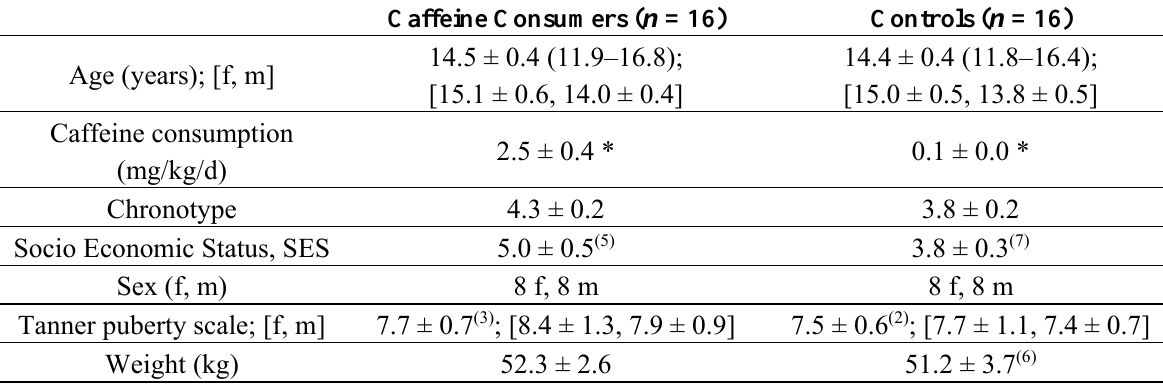
Table 1. Demographic characteristics of the caffeine consumers and the